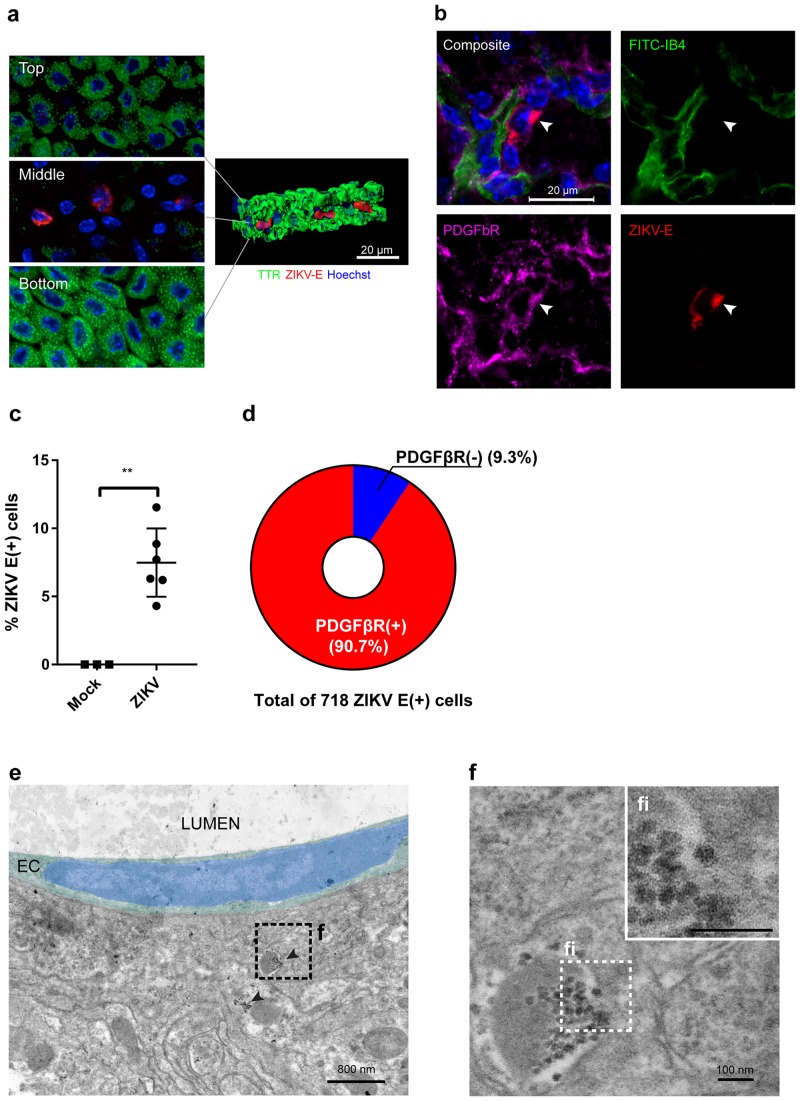
ZIKV infects pericytes in the choroid plexus.a-d, Ifnar-/- mice were infected with ZIKV as above, and the choroid plexuses were isolated at 4 DPI. a, Choroid plexuses were stained with antibodies against TTR (choroid plexus epithelial cell maker, green) and ZIKV-E protein (red). left: three layers of confocal images (labeled with Top, Middle, and Bottom) along the Z-axis. right: a three-dimensional reconstruction of the z-stacked image, highlighting the ZIKV-infected cells in the stroma layer of the choroid plexus. The top, middle, and bottom layers showed TTR+/ZIKV-, TTR-/ZIKV+, and TTR+/ZIKV-, respectively. A representative image is shown. b, Choroid plexuses were costained with FITC-IB4 for capillaries (green), anti-PDGFβR antibody for pericytes (purple), and anti-ZIKV-E antibody for the Zika envelope protein (red). Nuclei were stained with Hoechst 3342 stain (blue). The ZIKV-E signal colocalized with PDGFβR. For a and b, scale bars = 20 μm. c-d, ChP (n = 6, two from three mice) were harvested following cardiac perfusion and stained with anti-PDGFβR antibody for pericytes, anti-ZIKV-E antibody for the Zika envelope protein, and Hoechst 33342 for nuclei. (See S8 Fig for detail). The percentage of ZIKV-infected cells in the total ChP stromal cells(c) and PDGFβR (+) populations in the ZIKV (+) cells (d) were enumerated by using Imaris image analysis software. Each symbol represents an individual choroid plexus** P <0.01 (Student’s t-test). e, An electron micrograph showing a pericyte infected with ZIKV on a choroid plexus capillary. Pseudocolors (green and blue) indicate the cytoplasm and the nucleus, respectively, of a choroid plexus endothelial cell (EC) facing the lumen of a capillary (LUMEN). Patches of electron-dense particles (arrowheads) were found in a pericyte next to the EC. f, A higher magnification of the image from e shows that the particles have characteristics typical of flavivirus nucleocapsids. fi, A higher magnification image of the inset area of Fig e, Scale bars: 800 nm in e and 100 nm in f and fi.